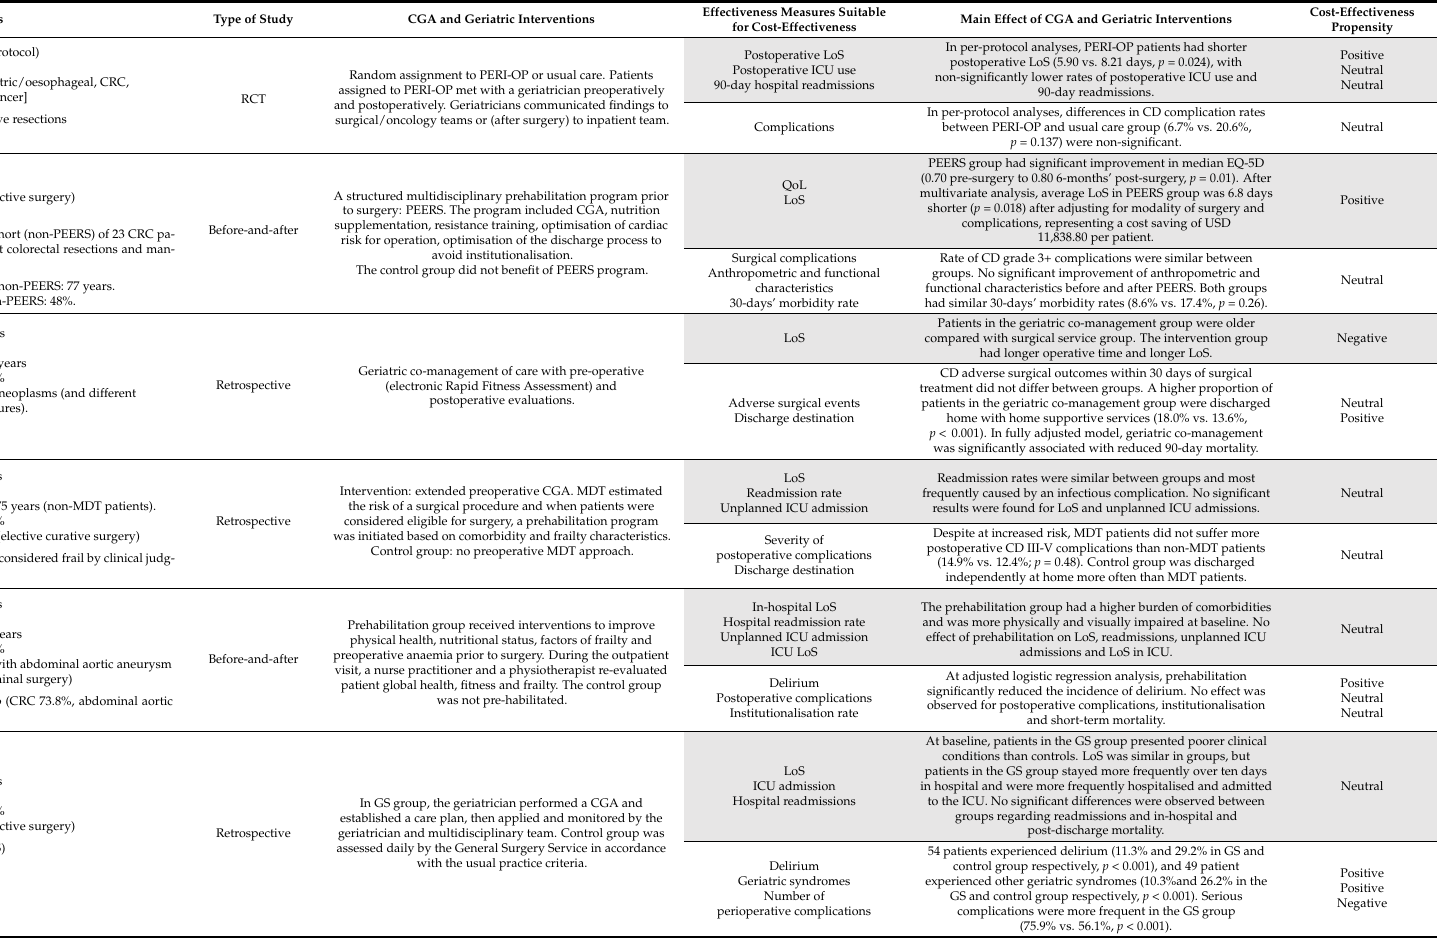
Table 2. Studies conducted in surgical settings, main features and